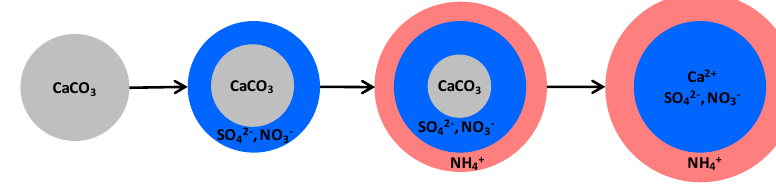
Fig. 7. A conceptual model showing the four-stage aging for the carbonate-containing Fig. 7. Conceptual model showing the four aging stages for the carbonate-containing dust particles. dust particles. Table 2. Concentrations of nitrite in TSP, nitrate in TSP and BC in Table 3. Concentrations of titanium and nitrite in both fine parti- PM 2 . 5 measured during the dust storm of 24–26 April and a non- cle mode (PM 2 . 5 ) and coarse particle mode (PM > 2 . 5 ) in the two dust pollution episode that occurred on 8–9 May at Mt. Heng. daytime samples during the dust storm of 24–26 April at Mt. Heng. DS-II